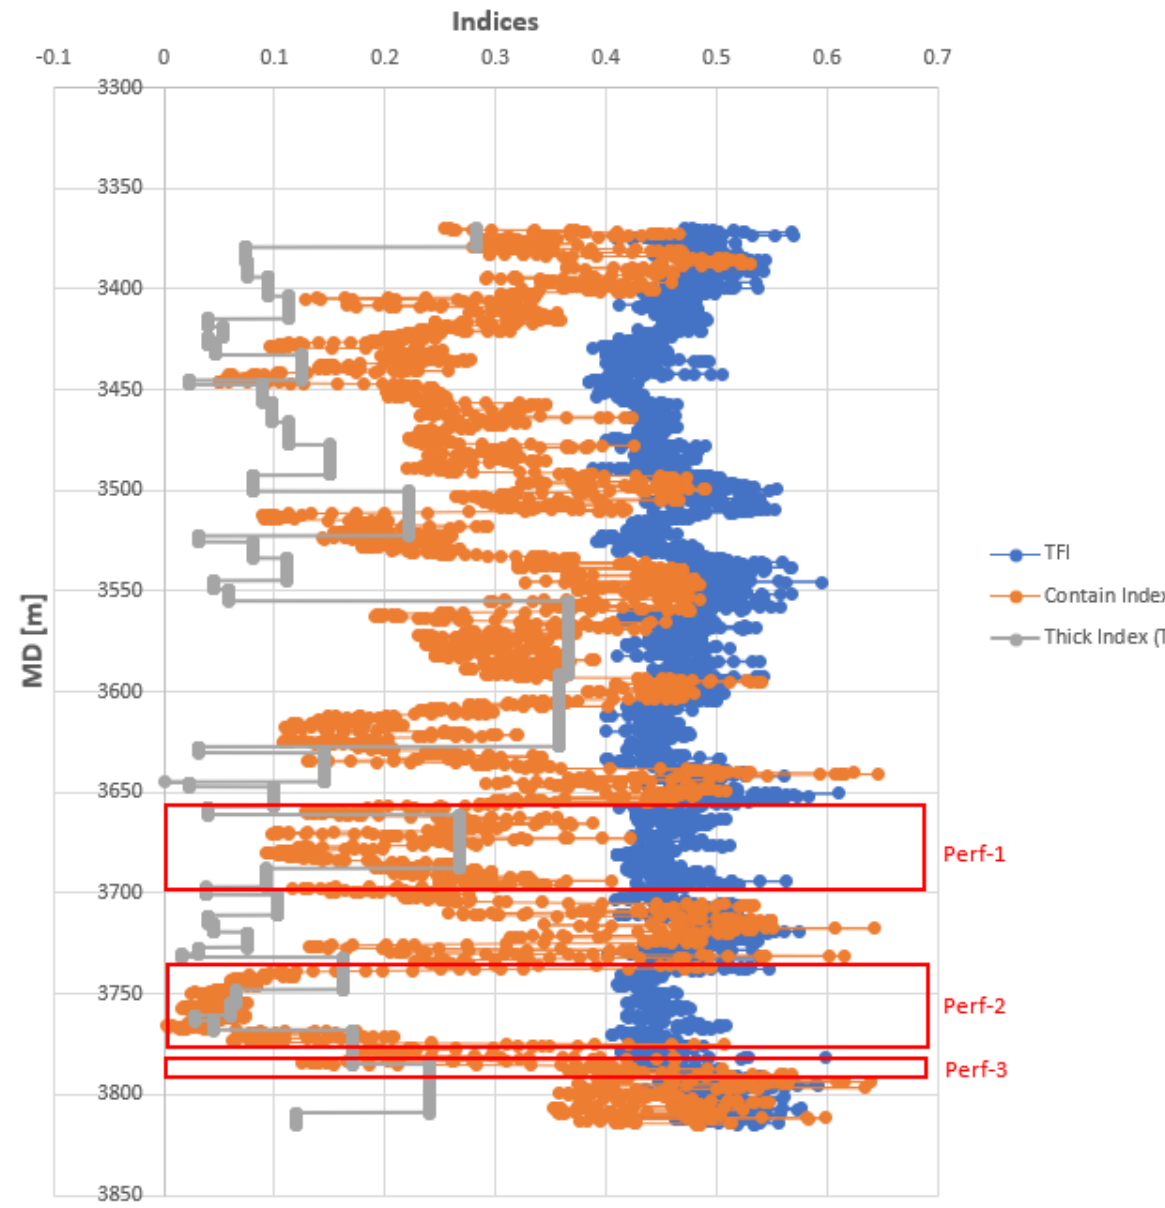
Figure 6. Candidate selection from the three perforation intervals for hydraulic fracturing.